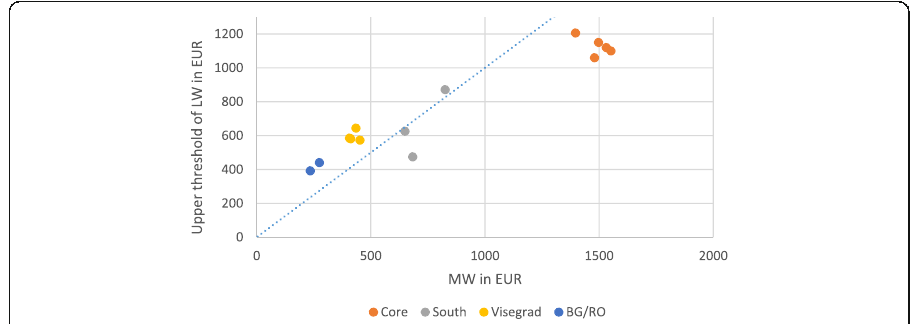
Fig. 2 Graphical distribution of countries based on individual MW and LW. Source: own calculation based on WI from December 2016. Q1 2017 Eurostat data used for